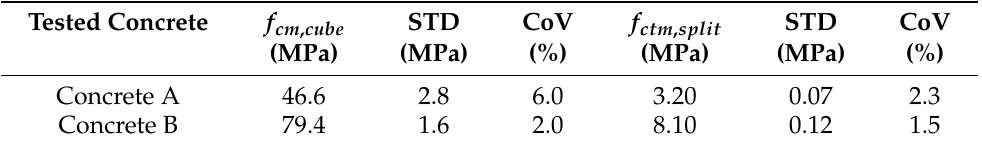
Table 3. Results of the strength tests for the